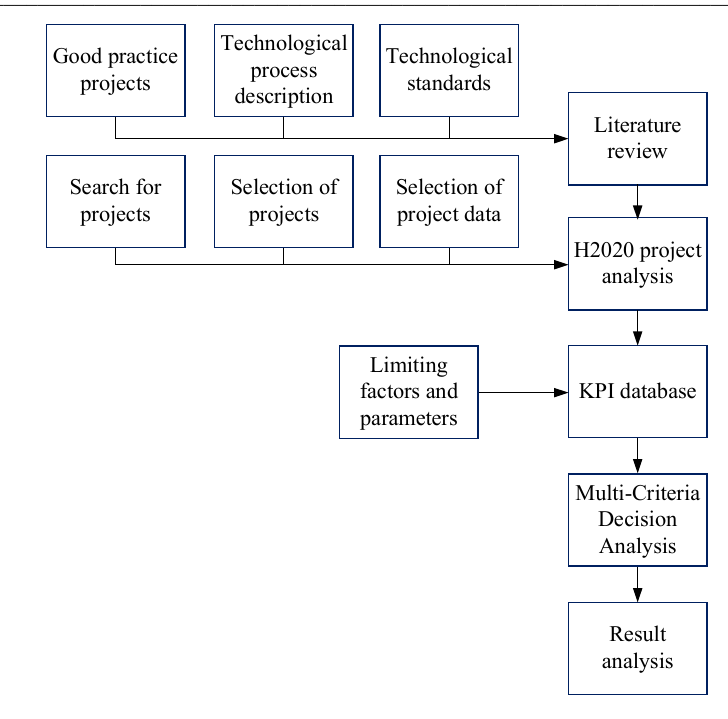
Fig. 3. Methodological